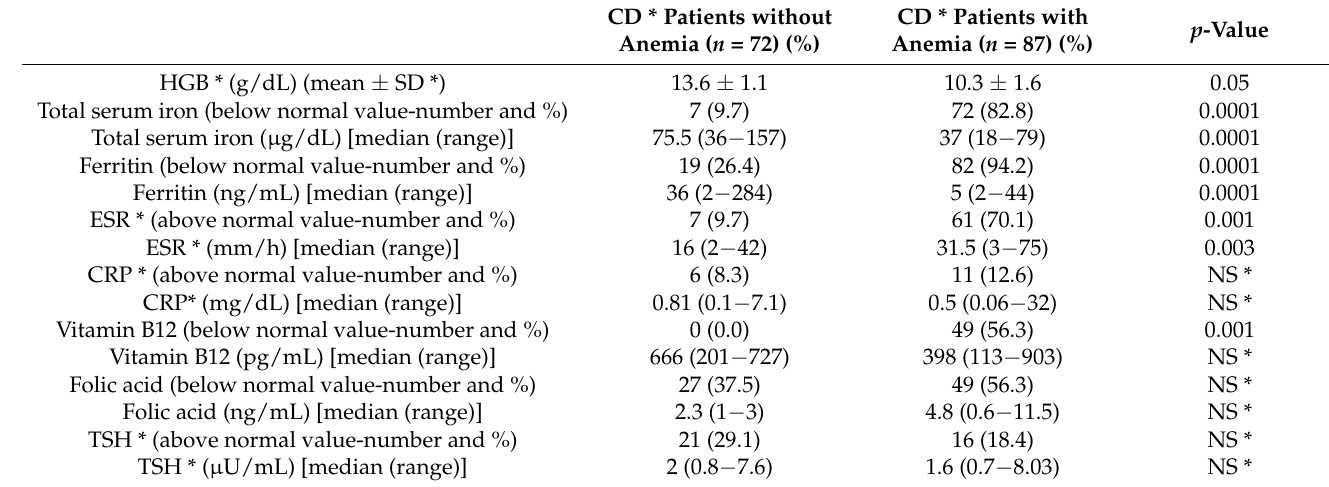
Table 2. HGB, iron metabolism, ESR, CRP, vitamin B12, folic acid and TSH of anemic and non-anemic CD